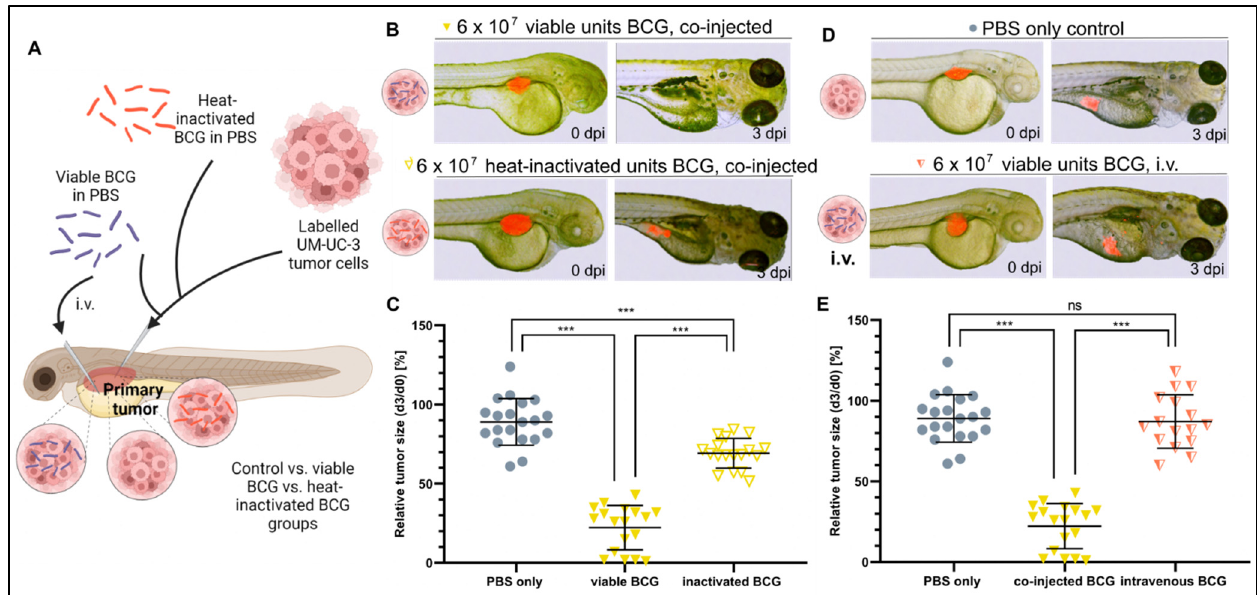
Figure 3. Heat inactivation and intravenous injection of BCG minimize the tumor-killing effect of BCG in UM-UC-3 xenografts. ( A ) Cartoon illustrating the experimental setup. Fluorescently labelled UM-UC-3 tumor cells alone or mixed with either viable (blue) or heat-inactivated (red) BCG were injected into the PVS of 2-day-old zebrafish larvae; alternatively, viable BCG was injected intravenously in subcutaneous tumor-bearing larvae. ( B ) Combined light and fluorescence micrographs at 0 days post injection (dpi) or 3 dpi of fluorescently labelled UM-UC-3 primary tumors mixed with either viable or head-inactivated BCG-Medac and implanted in 2-day-old zebrafish. ( C ) Graph showing the relative tumor size of control and BCG-co-injected larvae from the experiment shown in B. n = 24 injected embryos per group; ns = not significant; *** = p < 0.0001. ( D ) Combined light and fluorescence micrographs at 0 days post injection (dpi) or 3 dpi of fluorescently labelled UM-UC-3 primary tumors with or without intravenous BCG treatment. ( E ): Graph showing the relative tumor size of control, BCG co-injected, and BCG intravenously injected larvae from the experiment shown in D. n = 24 injected embryos per group; ns = not significant; *** = p < 0.0001.